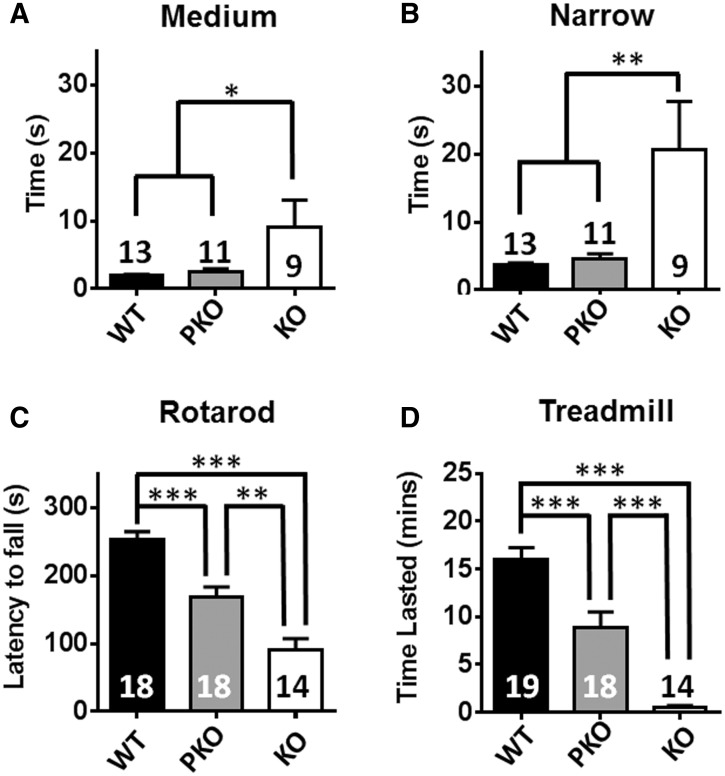
PKO mice show no difference in balance but marked deficiency in exercise capacity. (A–B) Balance beam task showing time to traverse medium (A) and narrow (B) beams. (C) Rotarod performance. (D) Exercise capacity measured using an elevated treadmill, with a steadily increasing speed. Results show time lasted on treadmill. Plots show mean ± S.E.M. Number of animals per genotype are shown within each bar. Groups were compared using one-way ANOVA and Tukey’s post hoc analysis. *P < 0.05, **P < 0.01, ***P < 0.001.